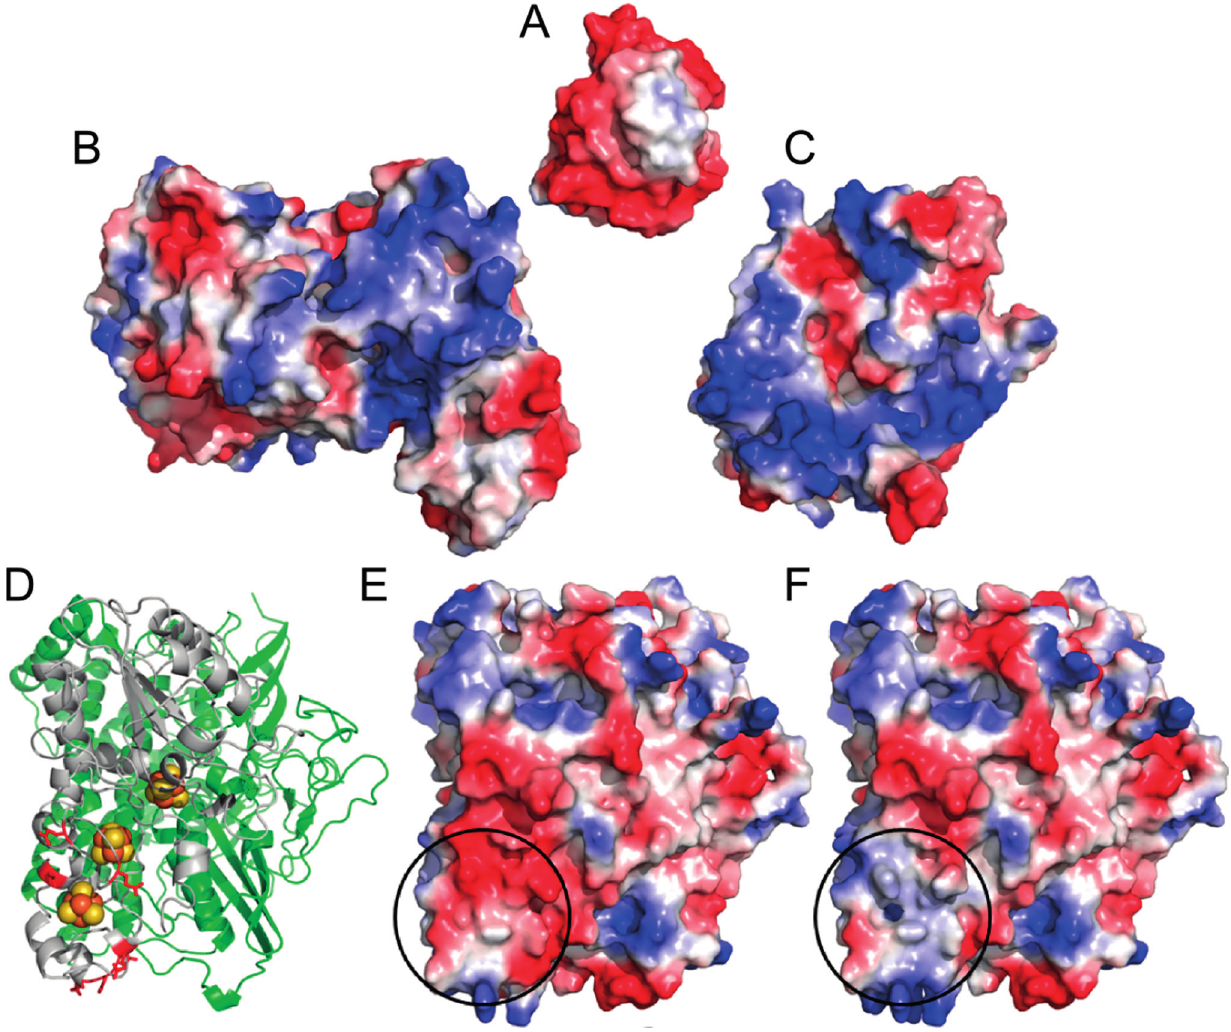
Figure 1. Electrostatic models of S. elongatus ferredoxin PetF ( A ); Spinacia oleracea PFOR (PDB: 1FNB) ( B ); Clostridial [FeFe] hydrogenase (PDB: 1FEH) ( C ); and a structural